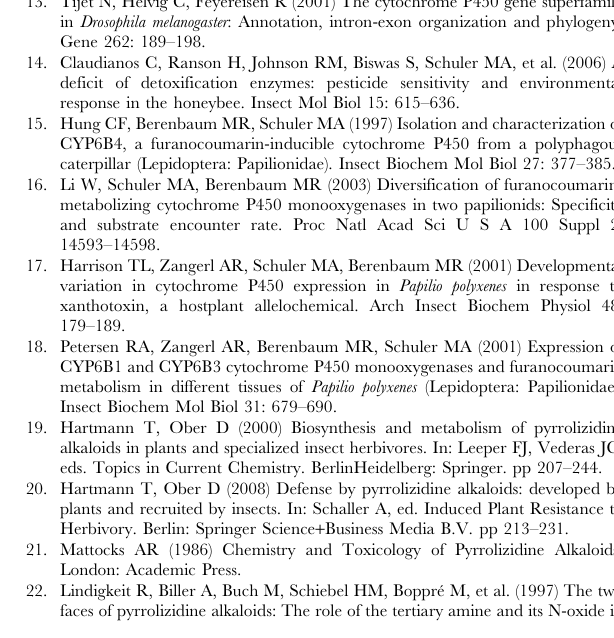
Table S3 Accession numbers of all nucleotide sequences that have been identified within this project and that have been taken from the